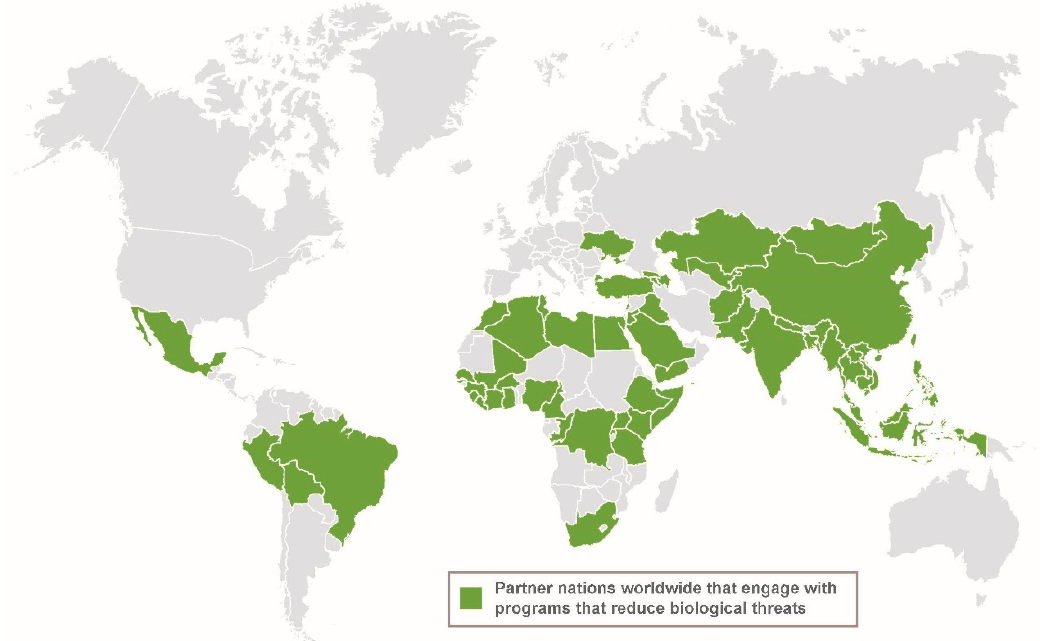
Figure 1. The governments of the US, Canada, Germany, and the United Kingdom fund programs that engage with over 40 countries worldwide to reduce biological threats. The countries represented are not necessarily engaged in current program